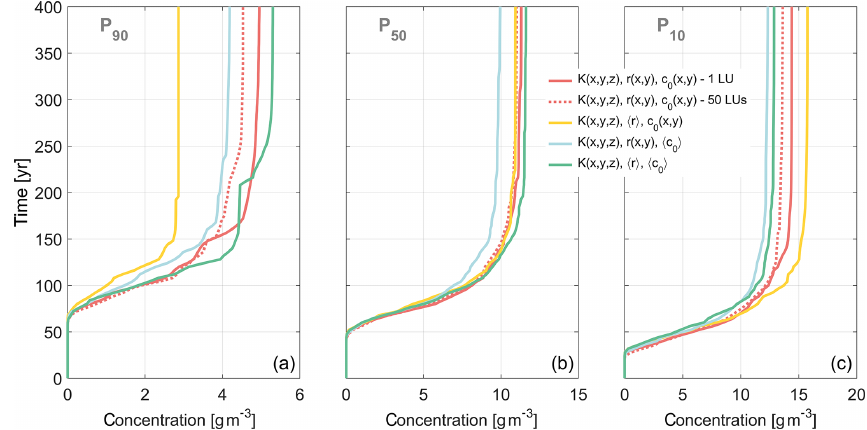
Figure 6. Time ( y axis) required for a well to exceed a given concentration ( x axis) with a probability of 90% (a) , 50% (b) and 10% (c) considering a heterogeneous r and heterogeneous c 0 (reference case, red line); a homogeneous r and heterogeneous c 0 (yellow line); a heterogeneous r and homogeneous c 0 (light blue line); and a homogeneous r and homogeneous c 0 (green line). For comparison, the red dash lines show outputs from simulations with a realization-dependent land-use